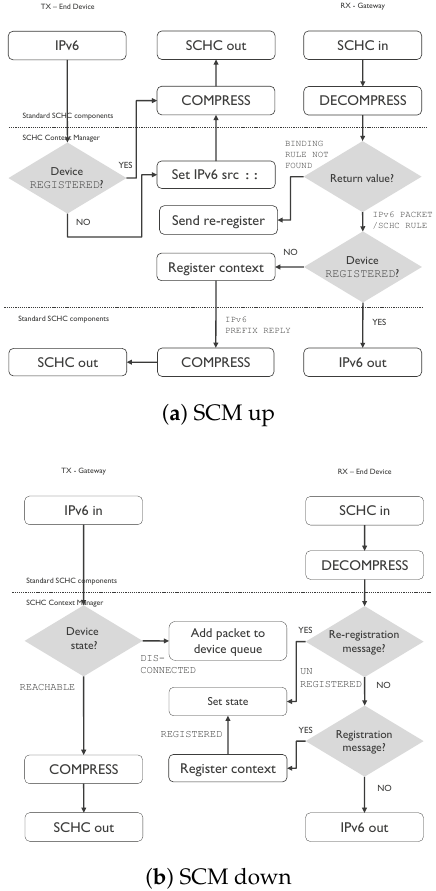
Figure 4. FSMfor the Context Manager in both directions. Figure 4b shows the FSMfor traffic flowing in the downward direction. If a